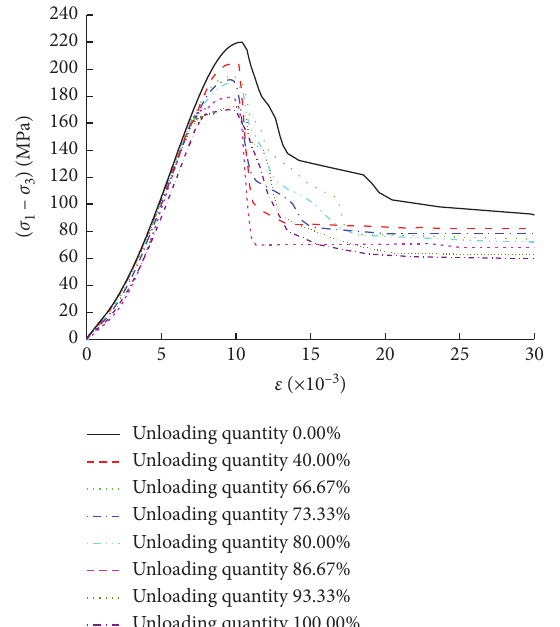
Figure 4: Stress-strain curves of rock samples with different unloading damage under triaxial compression.